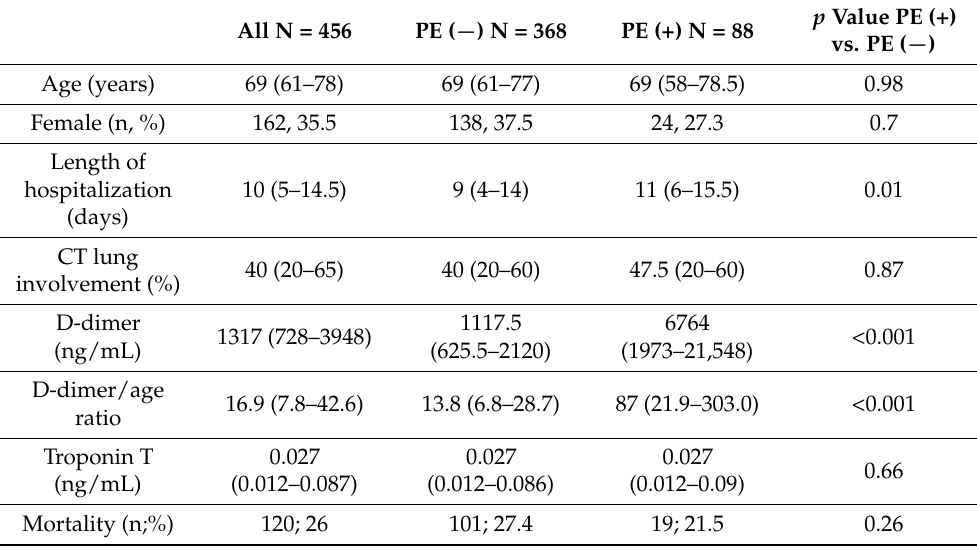
Table 1. Characteristic of the study group and a comparison of COVID-19 patients with pulmonary embolism (PE+) and without pulmonary embolism (PE − ). Data are presented as number (median, percentage) followed by interquartile range, where applicable.